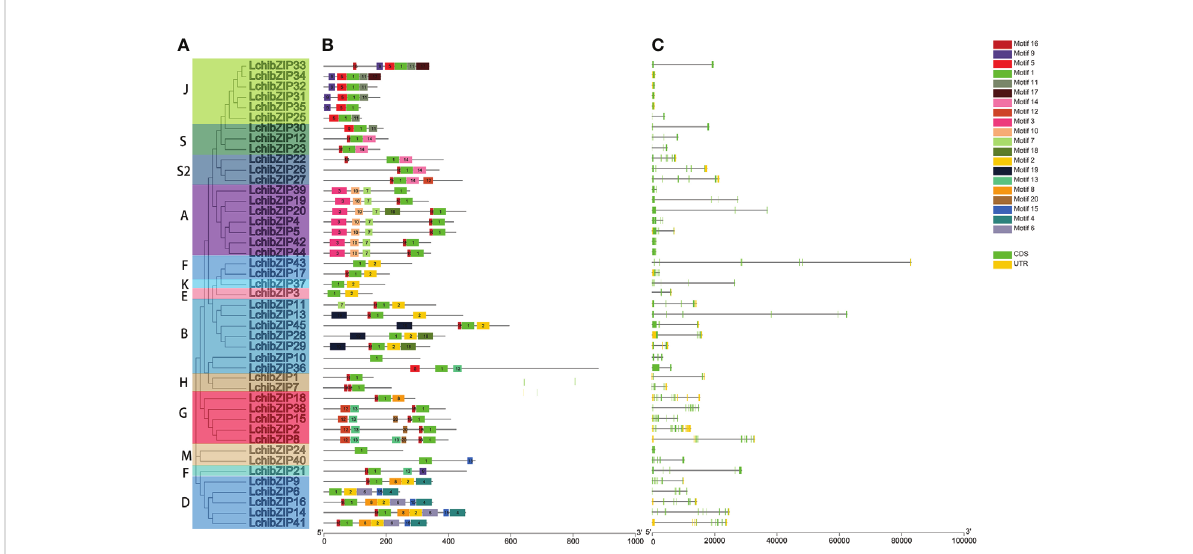
FIGURE 4 (A) phylogenetic relationship (B) gene structure and (C) conserved motifs of LchibZIPs. The gene structure dynamics of LchibZIPs were predicted using GSDS software. Exons are indicated by green boxes and introns are indicated by black lines. Conserved motifs were scanned with MEME. Different motifs are represented by different colored